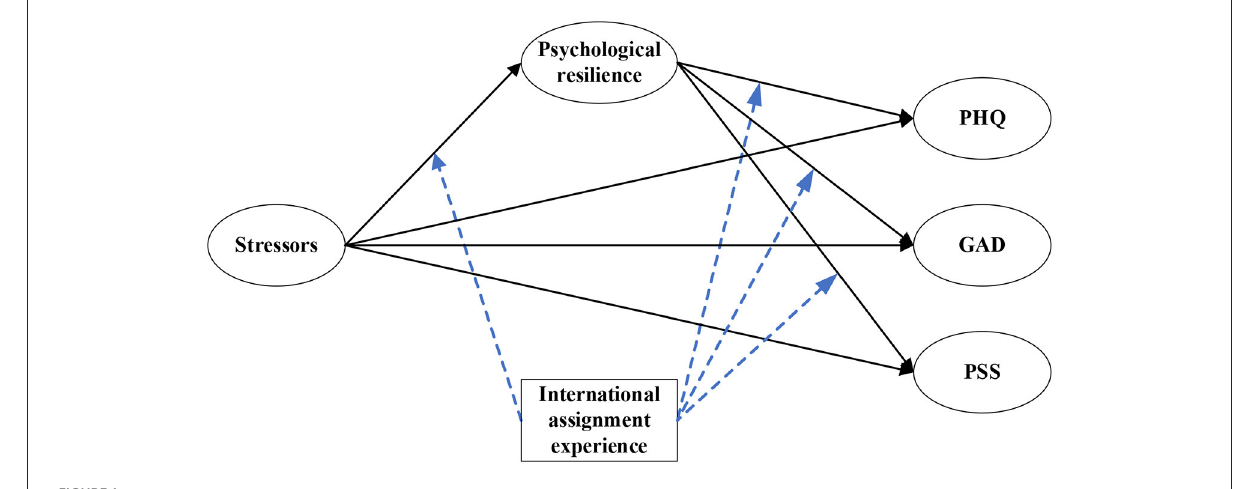
FIGURE1 Hypothesis